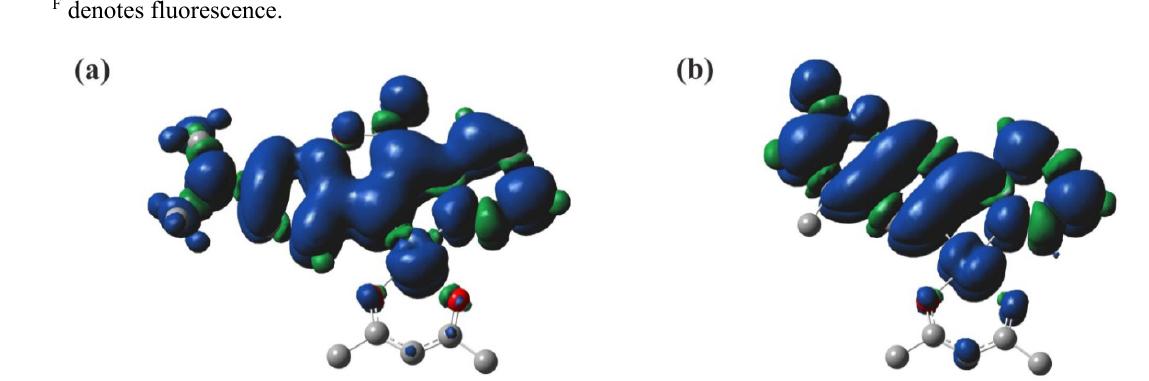
Figure 10. Spin-density surfaces for the triplet states T 1 of complexes 1 (a) and 2 (b)